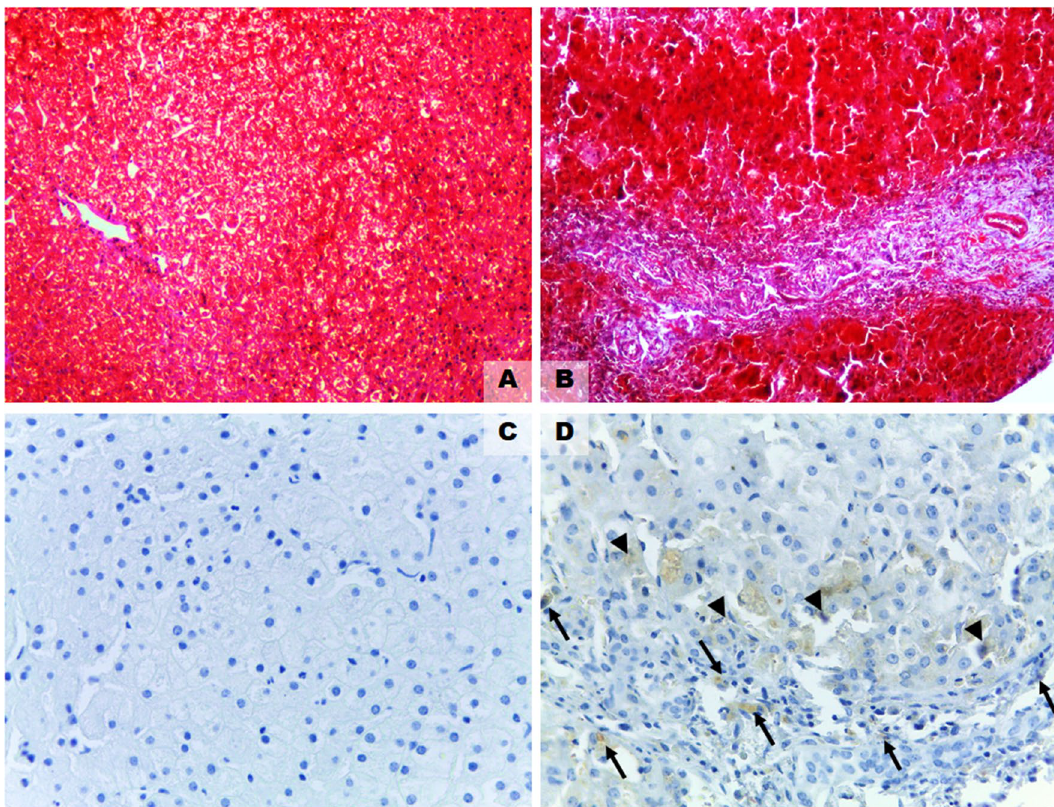
Figure 4. Histological staining with Masson’s Trichrome and immunohistochemistry in BA livers with and without the fibrotic scarring (original magnifications × 400). ( A ) Masson’s Trichrome staining in BA livers without fibrotic scarring. ( B ) Masson’s Trichrome staining in BA livers with fibrotic scarring. ( C ) Immunohistochemical staining for COMP protein expression in BA livers without fibrotic scarring. ( D